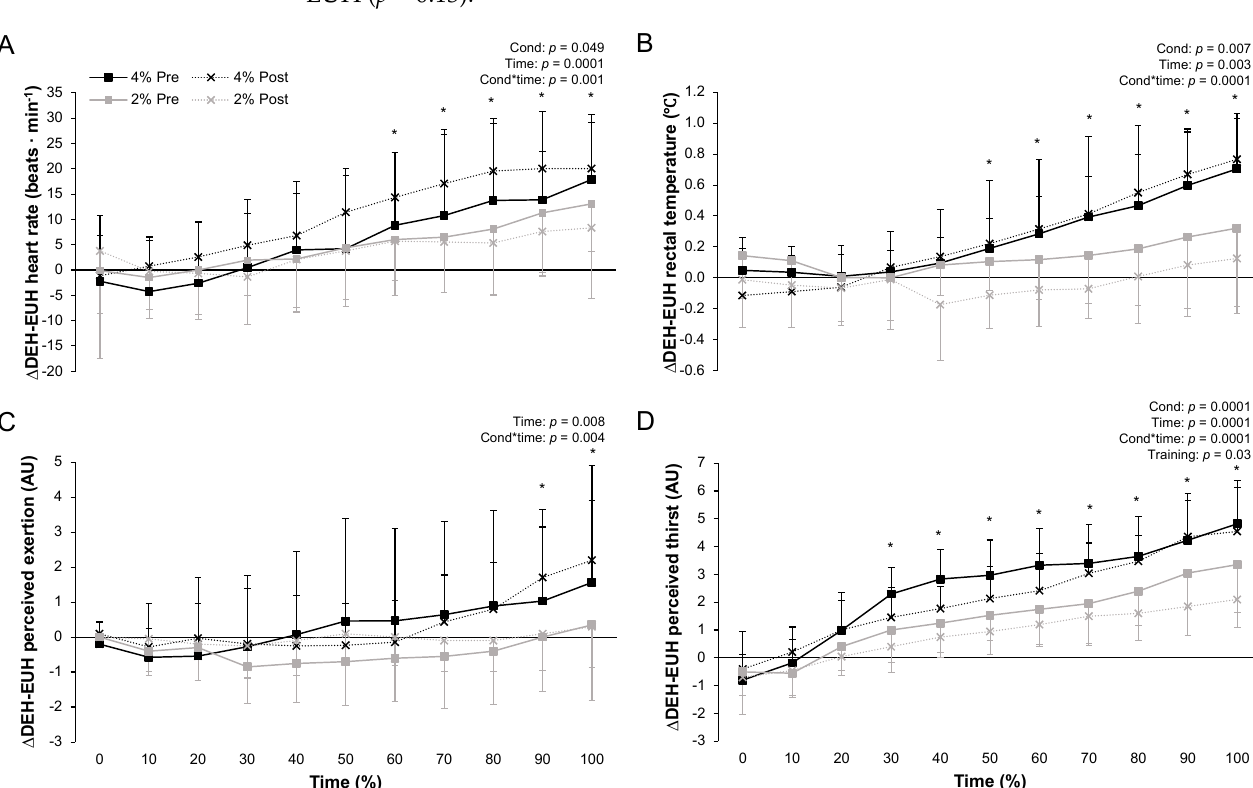
Figure 3. Differences between DEH and EUH during the fixed-intensity exercise periods for heart rate ( A ), rectal temperature ( B ), perceived exertion ( C ) and perceived thirst ( D ) through exercise time, while replacing or not 2 or 4% body mass losses, pre- and post-training. Δ = difference. Values are the means ± SD. EUH = euhydrated; DEH = dehydrated; Cond = condition (2 vs. 4%); Training = pre vs. post; Time = % of the fixed-intensity exercise completed. Only the significant effects are reported. * p < 0.05 2 vs. 4%.